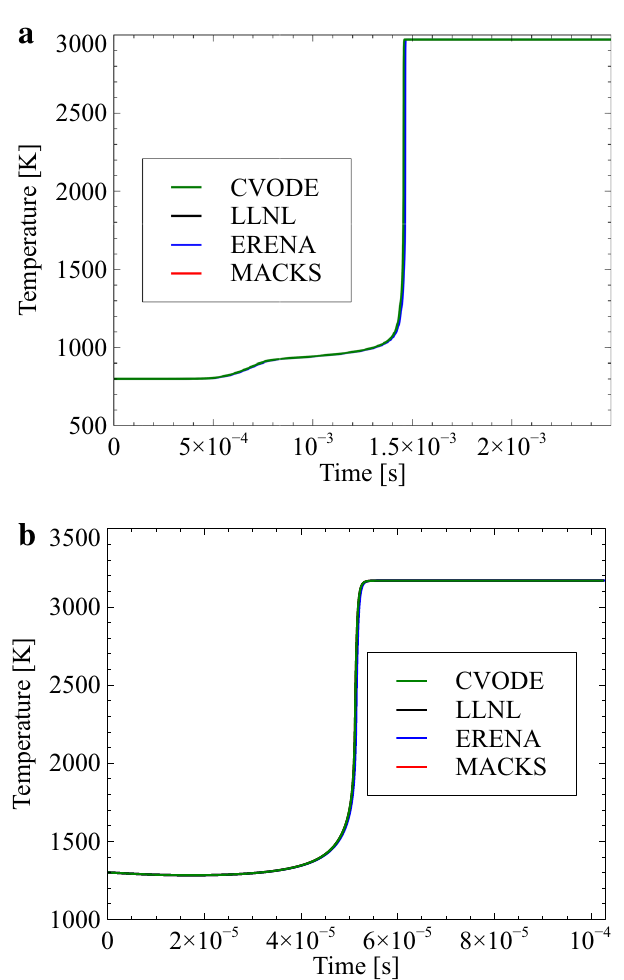
Figure 8. Time histories of temperature with CVODE, LLNL, ERENA, and MACKS for a n - C 7 H 16 /air mixture 8 s with h = 1 × 10 − , p 0 = 2.0MPa , and T 0 = 800 and 1300